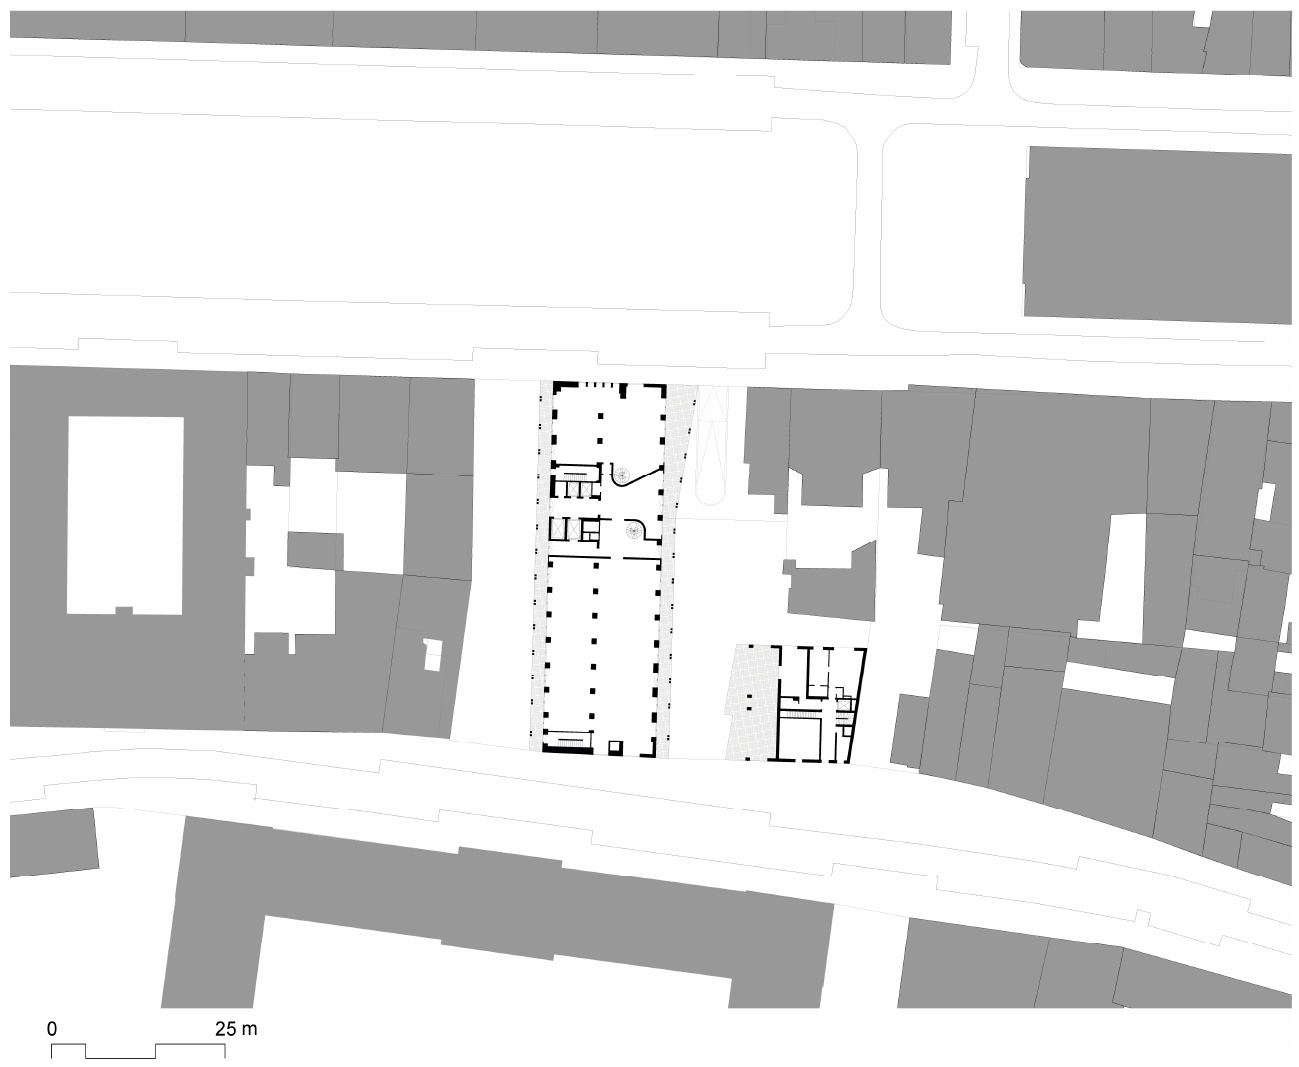
Figure 13. Urban layout of the project “Cosmopolitan” by Bogdan and Van Broeck architects (re-drawing by the authors).